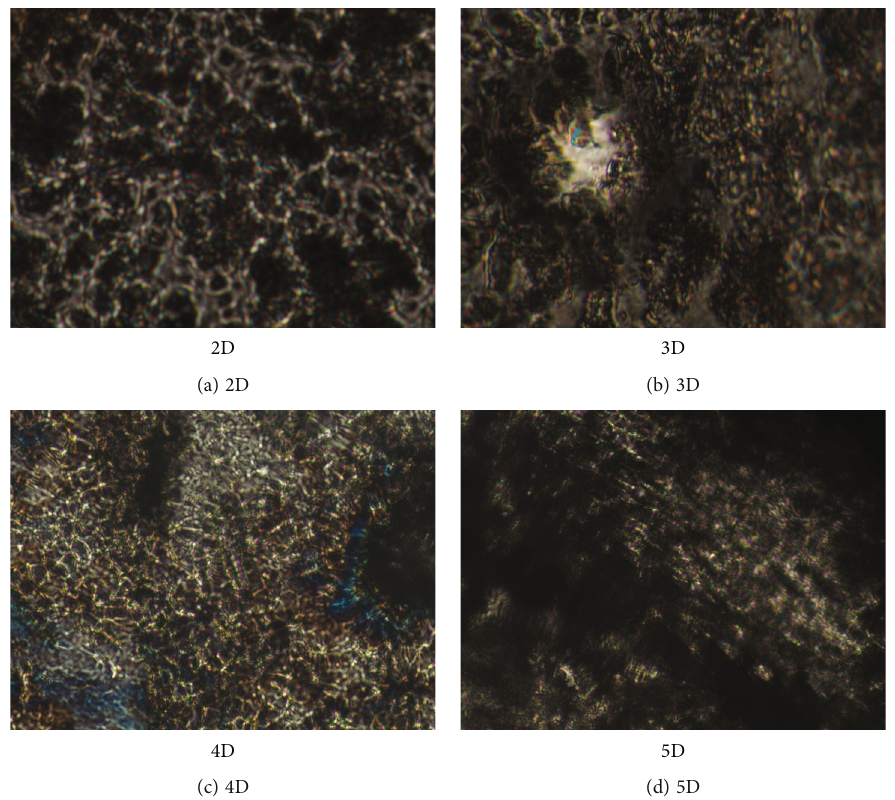
Figure 1: Birefringent textures of the 2D – 5D formulations evidenced by